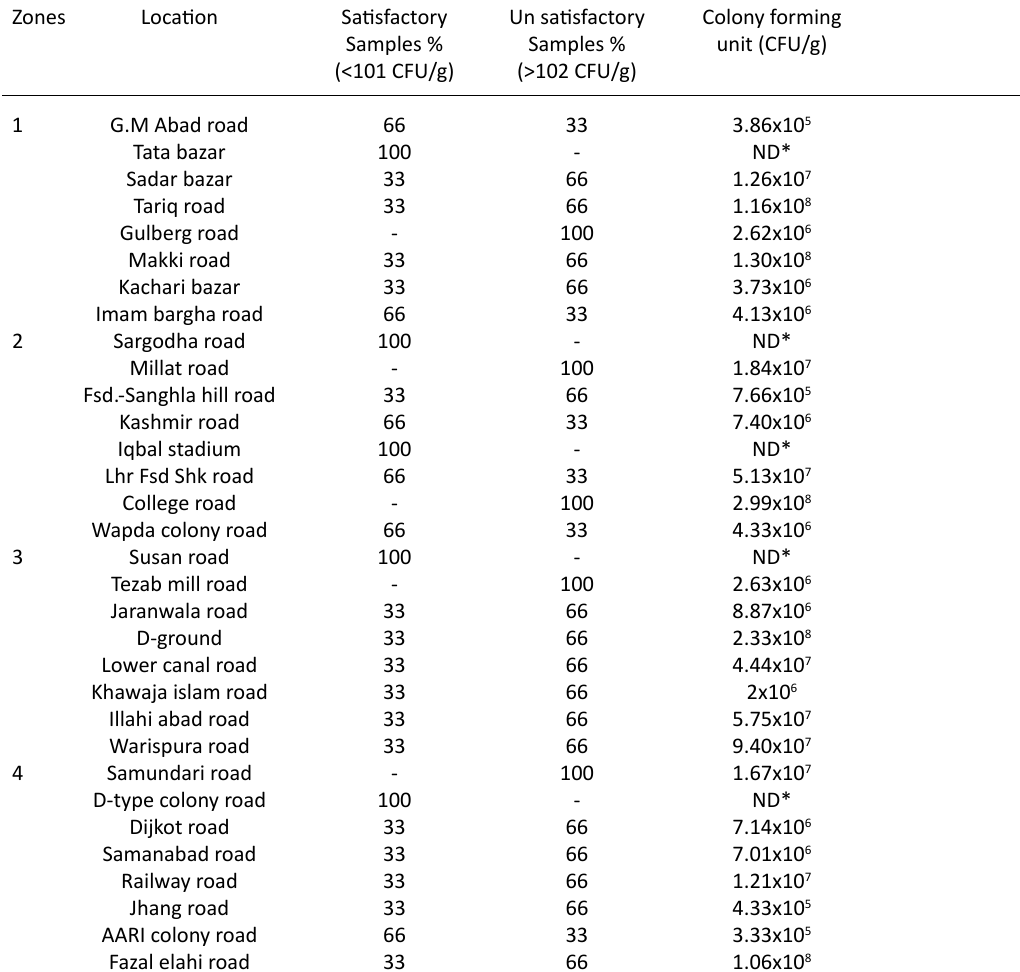
Table 4. Prevalence and enumeration of Listeria in Russian salad Zones Location Satisfactory Un satisfactory Colony